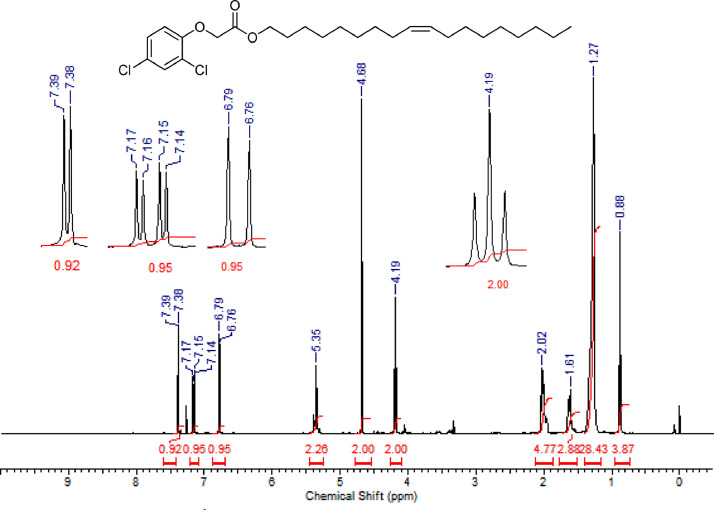
1H NMR (CDCl3, 400 MHz) spectrum of compound 6c.